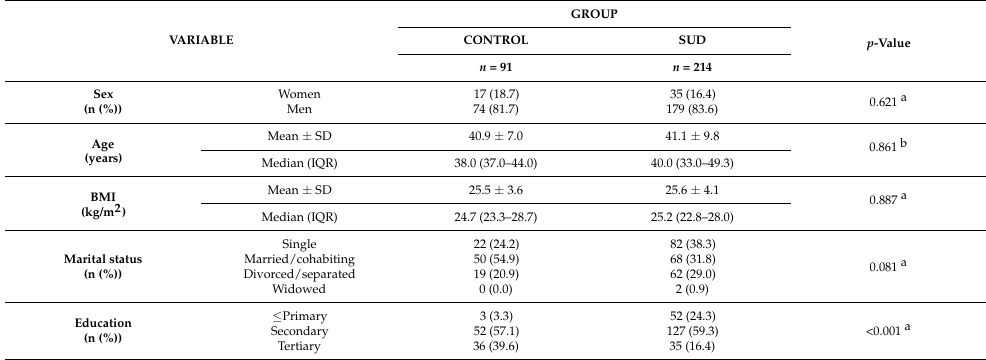
Table 1. Baseline sociodemographic characteristics.